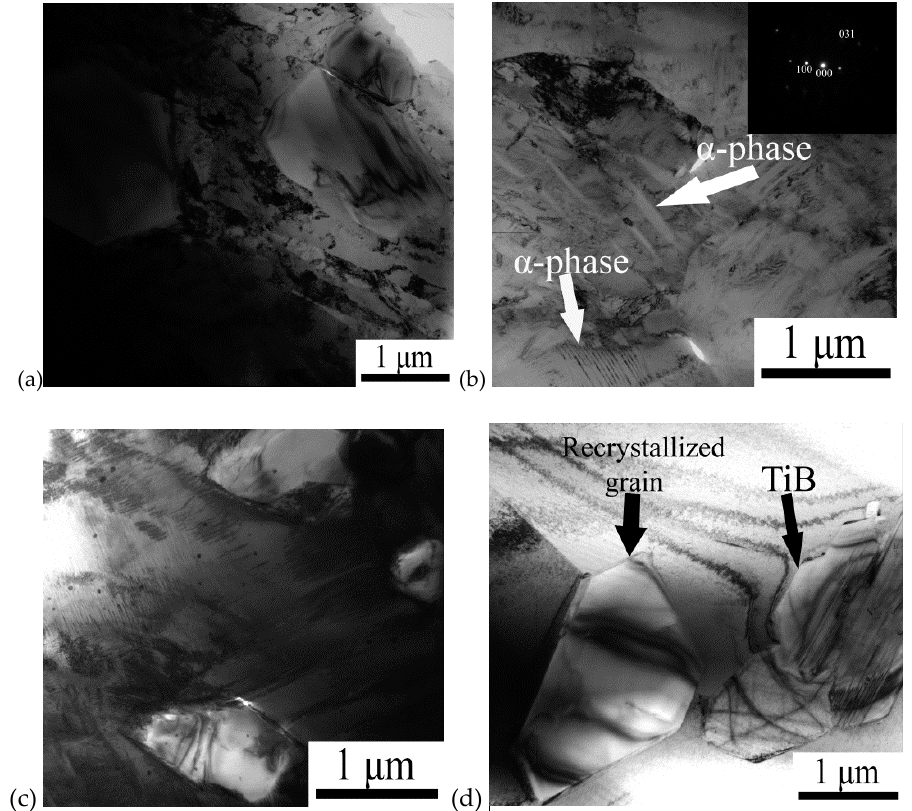
Figure 6. TEM microstructure of the Ti-15Mo/TiB TMC after uniaxial compression at ( a , b ) 600 ° С , ( c ) 800 ° С and ( d ) 1000 ° С . Selected area diffraction pattern for the α -phase is inserted in ( b ).